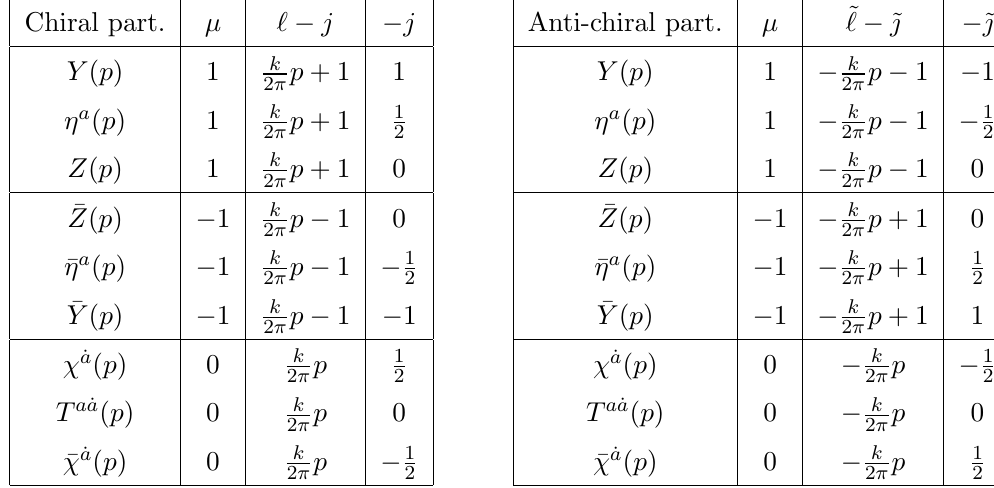
Table 1 . The particle spectrum of pure-NS-NS AdS 3 (cid:2) S 3 (cid:2) T 4 Green-Schwarz strings. We have eight bosons: two correspond to transverse modes on AdS 3 ( Z; (cid:22) Z ), two to transverse modes on S 3 ( Y; (cid:22) Y ), and four to the torus ( T a _ a ). The latter transform under so (4) 2 = su (2) (cid:15) (cid:8) su (2) (cid:14) . We group them in blocks with the fermions, corresponding to four ( 2 j 2 ) supersymmetric representations [27]; notice that all torus excitations carry an index _ a (cid:24) su (2) (cid:14) . Particles in the same multiplet have the same dispersion (2.4), but potentially di(cid:11)erent R charge j (or ~ | ). Since particles are chiral, we list separately the case in which @ p H > 0 (left table, chiral particles) and the one where @ p H < 0 (right table, anti-chiral particles). In the former case, the light-cone energy is entirely given by left-charges ‘ (cid:0) j (while ~ ‘ = ~ | = 0), and viceversa in the latter. Notice that charges also \(cid:13)ip sign" when changing the momentum of a particle from the chiral region ( p > (cid:0) 2 (cid:25)(cid:22)=k ) to the anti-chiral one ( p < (cid:0) 2 (cid:25)(cid:22)=k ), i.e., j $ (cid:0) ~ | . This is because (cid:22) , which is the di(cid:11)erence of left and right charges, remains